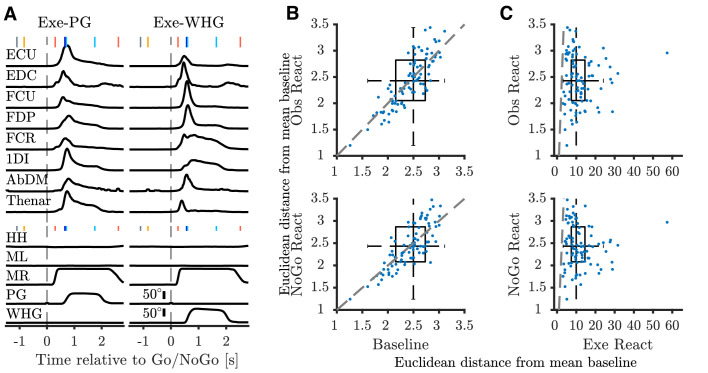
EMG during task.(A) Average execution EMG traces during a single session in M48. Top panels show pre-processed, rectified, and normalized EMG activity for different muscles with clean recordings for precision grip (PG) (left), and whole-hand grasp (WHG) (right). Bottom panels show corresponding average homepad and object displacement signals. Vertical markers at top of each trace indicate median time of task events relative to Go/NoGo cue (vertical dashed lines); colour coded as in Figure 1C. ECU, extensor carpi ulnaris; EDC, extensor digitorum communis; FCU, flexor carpi ulnaris; FDP, flexor digitorum profundus; FCR, flexor carpi radialis; 1DI, first dorsal interosseous; AbDM, abductor digiti minimi; HH, human homepad; ML, monkey left homepad; MR, monkey right homepad; PG precision grip; WHG, whole-hand grasp. (B) 2-D boxplot representation of Euclidean distance across muscles from mean baseline EMG. Blue dots show median value for each session (n = 93 total), dashed grey line denotes unity. (C) Distance from mean baseline of Observation React (top) and NoGo Reaction (bottom) periods vs. Execution Reaction.